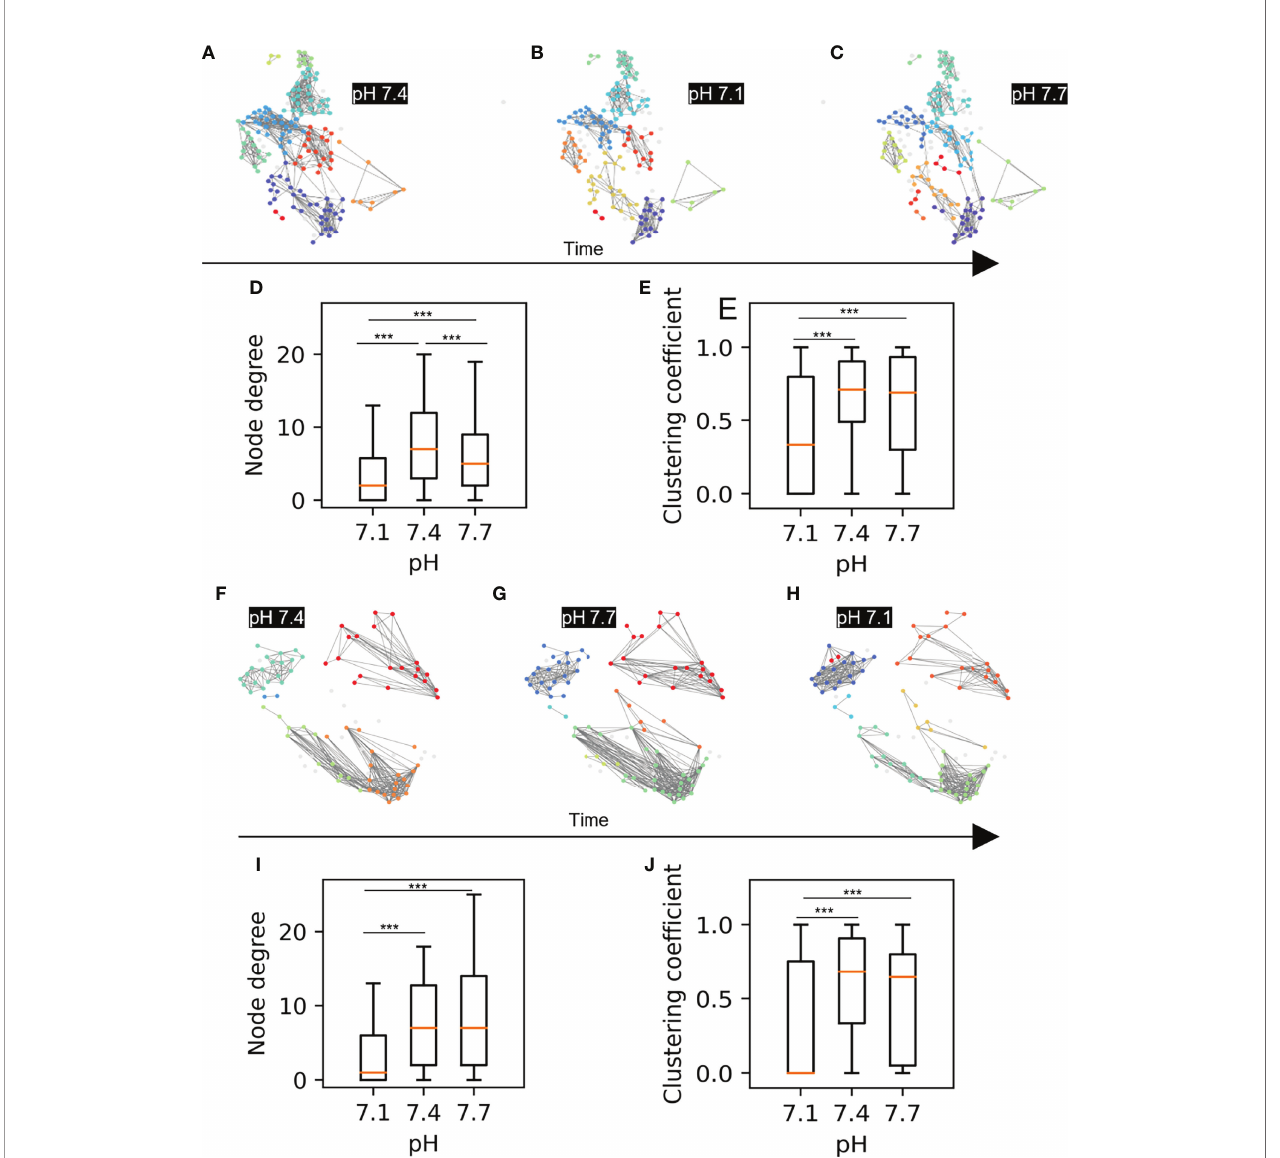
FIGURE 3 | Beta cell functional connectivity at different pH. (A) Functional networks of beta cells at 8 mM glucose and different pH changing in a sequence as indicated by the black arrow below: (A) 7.4, (B) 7.1, (C) 7.7. (D) Node degree of the pooled data for the sequence A-C. (E) Average clustering coef fi cient of the pooled data for the sequence A-C (F) Functional networks of beta cells at 8 mM glucose and different pH changing in a sequence as indicated by the black arrow: (F) 7.4, (G) 7.7, (H) 7.1 (I) Node degree of the pooled data for the sequence F-H. (J) Average clustering coef fi cient of the pooled data for the sequence F-H n=5 islets for each condition in the sequence A-C and n=3 for the sequence F-H. Box plots are showing upper and lower quartile; line median; whiskers 5- 95%. (***p <